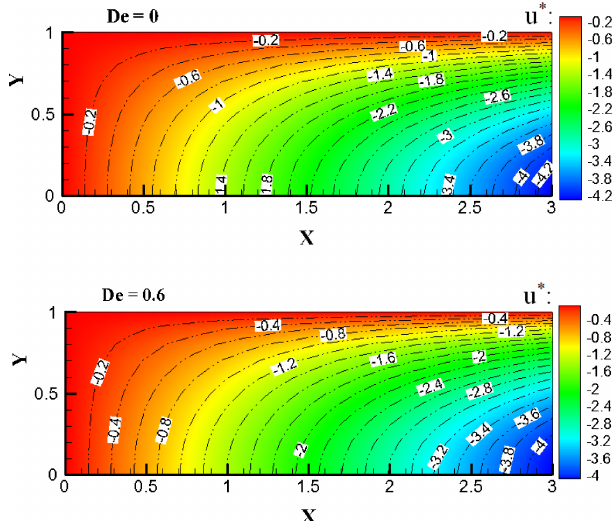
Figure 6. Effects of De Deborah numbers on the velocity contours for M = 1, Pr = 1, Re w = 3.